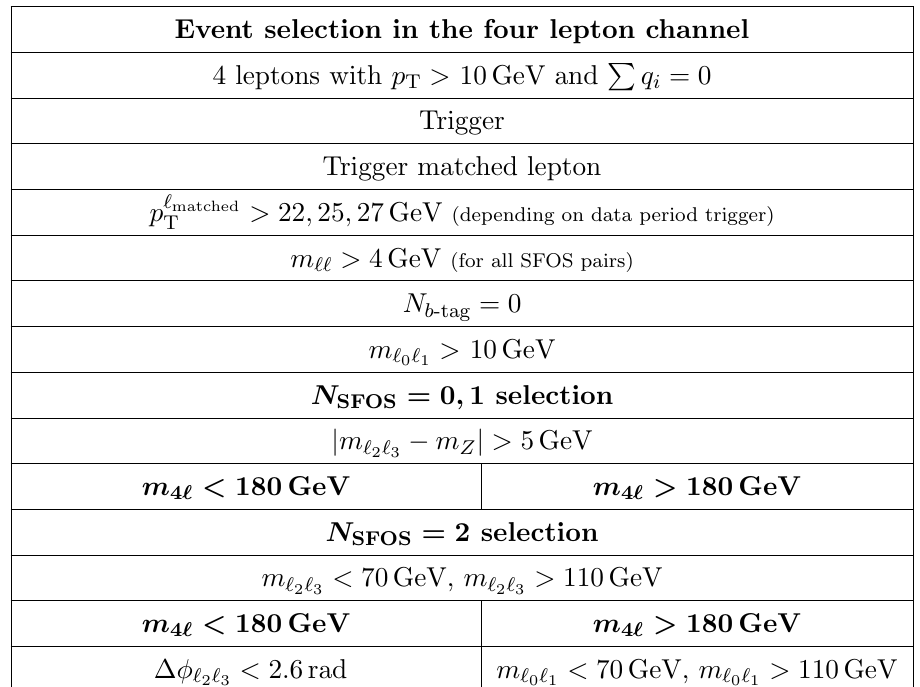
Table 11 . Summary of the selection criteria used in the four lepton channel. All events are required to pass the common selection and then category-dependent selection criteria are applied according to the number of same-(cid:13)avour opposite-sign lepton pairs in the